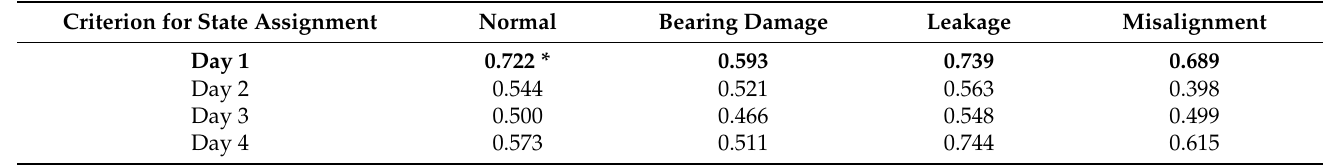
Table 5. Classified results of SVM when PF–IFF is not used.